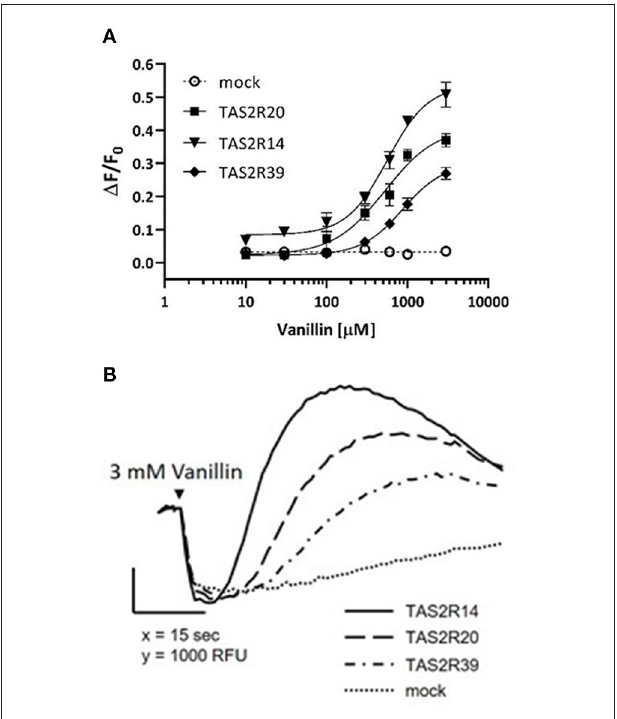
FIGURE 2 | Vanillin activity on human TAS2R14, TAS2R20, and TAS2R39 bitter taste receptors. (A) The figure shows dose-response curves obtained after stimulation of HEK293 PEAKrapid G α 16Gi/o44 cells overexpressing TAS2R14 (black filled triangles), TAS2R20 (black filled squares), and TAS2R39 (black filled diamonds). Responses of mock-transfected cells (empty plasmid) are indicated by the dotted line. Error bars represent the standard deviation. Experimental data are the full points, curve fitting is represented by the solid line. (B) Calcium-responses of TAS2R14 (solid line), TAS2R20 (dashed line), and TAS2R39 (dash-dotted line) expressing cells to 3mM vanillin. Receptor-expressing cells were loaded with the calcium indicator and fluorescence emissions recorded before and after exposure of the cells to vanillin. Responses of mock-transfected cells to the same concentration of vanillin is shown as negative control (dotted